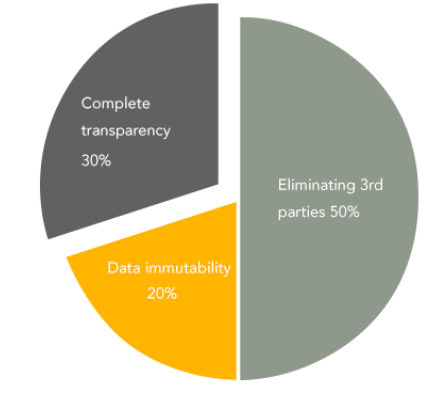
Figure 1. Overview of preventive capacity of blockchain technology for corruption.